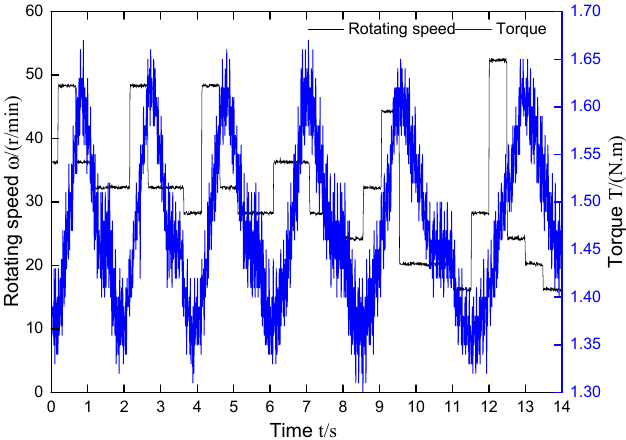
Figure 11. The change process of torque and rotating speed in Case 2. Figure 12 shows the changes in the rotator torque and rotating speed under the case 3. When the experiment cycle is 1.26 s and the wave height is 0.14 m, the average torque is 1.49 N.m, the average rotating speed is 48.91 r/min, and the generator can operate normally under this operating condition.